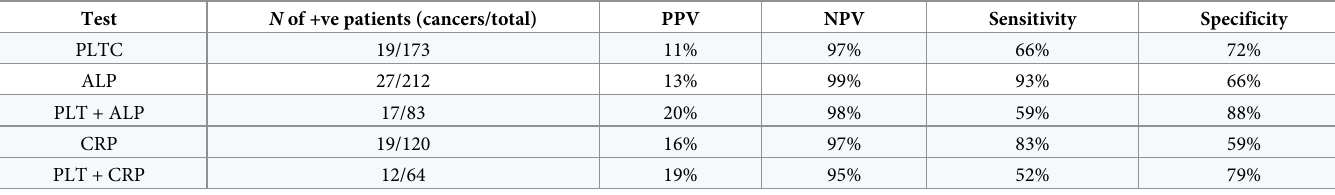
Table 2. Reliability and validity of all proposed tests for cancer detection.